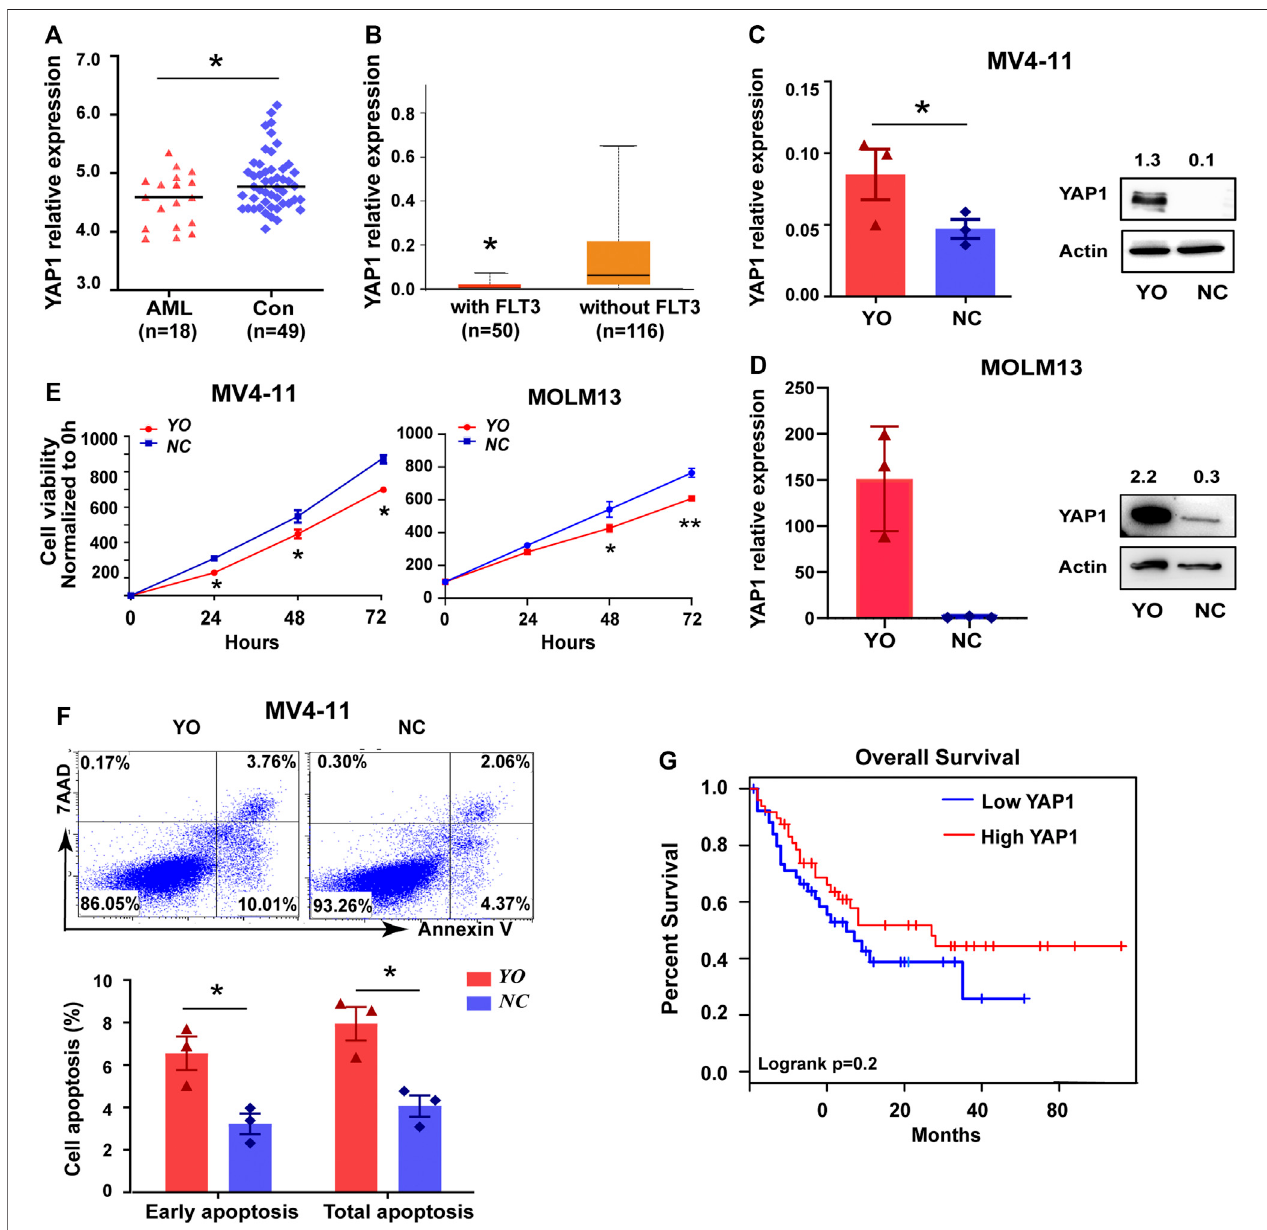
FIGURE 1 | YAP1 plays a tumor suppressor role in FLT3-ITD + AML. (A) YAP1 expression in AML patient samples ( n = 18, red) and control BM samples ( n = 49, blue) from GEO database, GSE48558. (B) YAP1 expression in FLT3 mutant AML patients ( n = 50, red) and without FLT3 mutant AML patients ( n = 116, orange) from TCGA database. (C) and (D) YAP1 overexpression (YO) or control (NC) MV4-11 cells and MOLM13 cells were selected by puromycin, followed by RT-qPCR and Western blot with indicated antibodies. (E) Proliferation ofYO and NC cells were assessed by CCK8 assays, and proliferation rates at 0, 12, 24, 48, and 72 h were calculatednormalized totheabsorbanceat 0 h. (F) ApoptosisofYOandNC cellsweremeasured by fl owcytometry. (G) OSanalysisofAML patients ( n =101)usingthe expression of YAP1 from TCGA database. Data are shown as mean ± SD of three independent experiments; * p < 0.05.